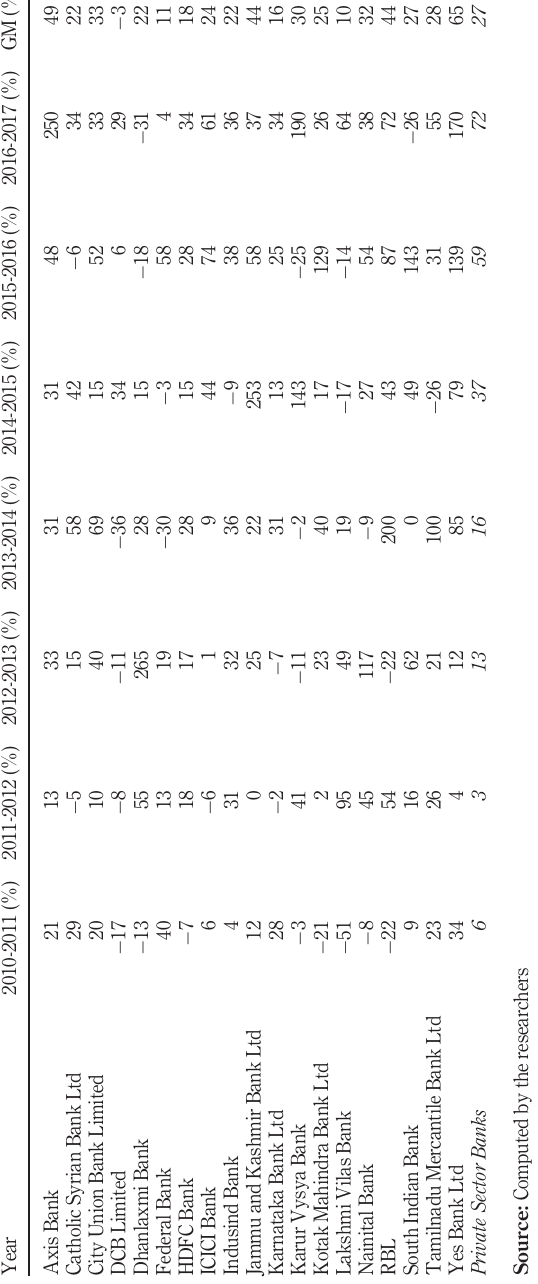
Table I. Year on year growth rate in gross NPAs in private sector